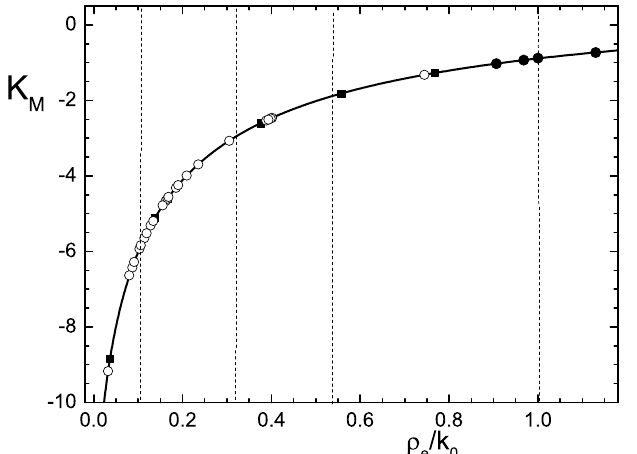
Figure 2. Plot of quantity K M as a function of normalized electron density ρ e / k 0 from Equation (16). Black circles and squares indicate values corresponding to materials listed in Table 1. Open circles indicate values corresponding to all the materials listed in Table 2. These data are discussed in text. Vertical dashed lines refer to selected values for curves with constant ρ e / k 0 plotted in Figure 3.